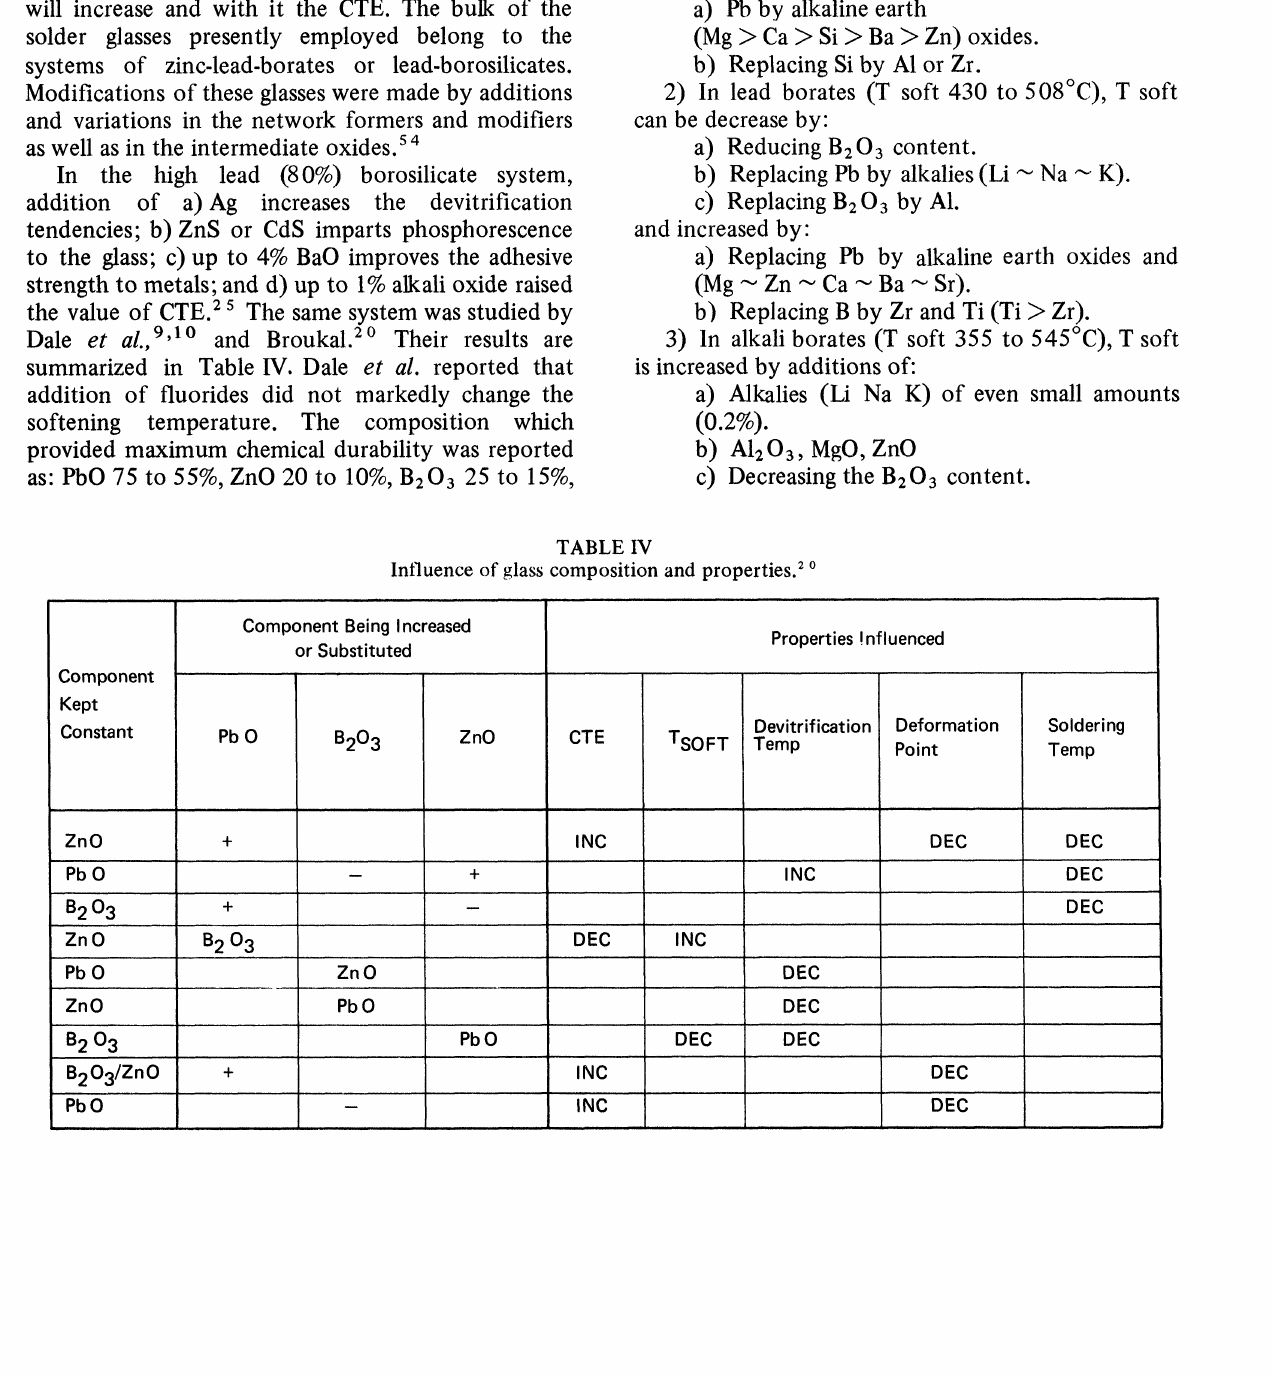
TABLE IV Influence of glass composition and